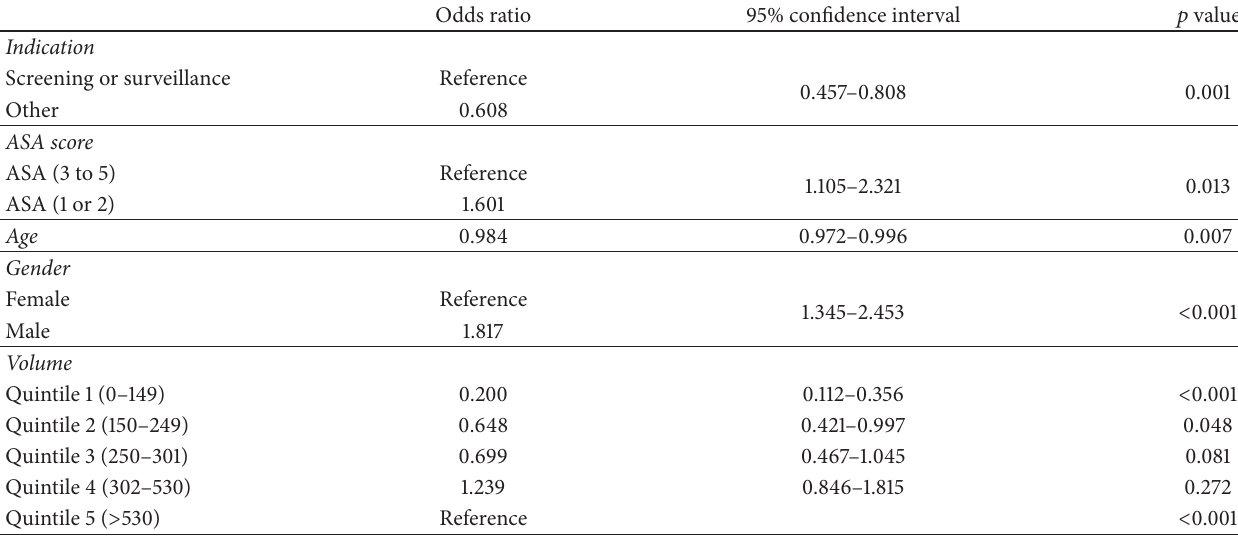
Table 4: Multivariable logistic regression model for colonoscopy completion rate.